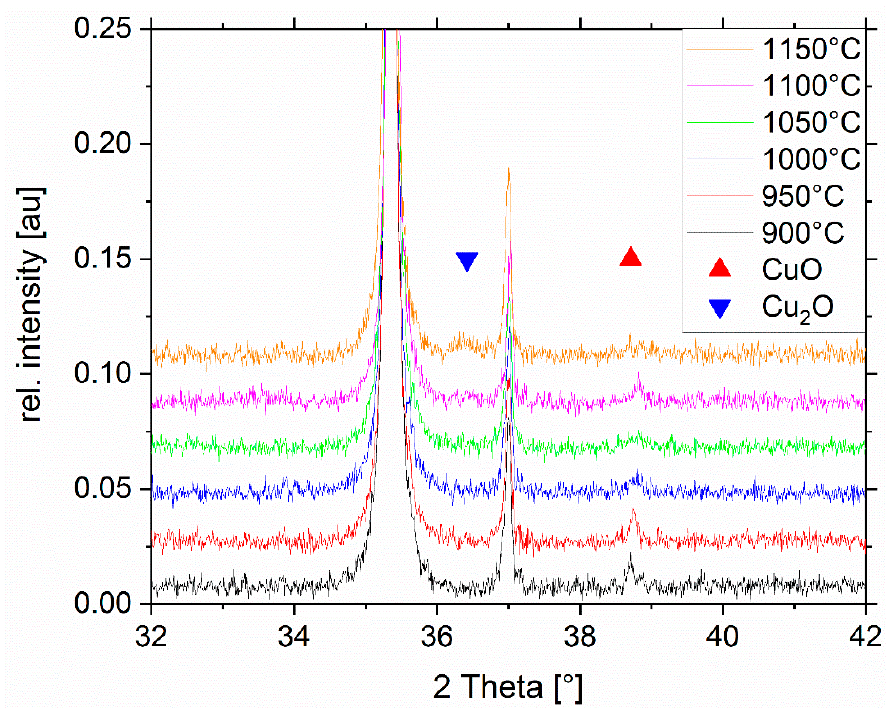
Figure 5. XRD patterns of z = 0.06 sintered at temperatures of 900–1150 ◦ C. This peak was hardly detectable in the ferrite with z = 0.02, because, in that case, the CuO concentration seems to be below the XRD detection limit. For a sample with z = 0.06 sintered at 1150 ◦ C, this CuO peak disappears and another one at about 2 θ = 36.4 ◦ is found, which confirms a phase transition into cuprite Cu 2 O (Figure 5). The cubic lattice parame- ters a 0 of the spinel ferrites with z = 0, 0.02, and 0.06 are plotted versus sintering tempera-